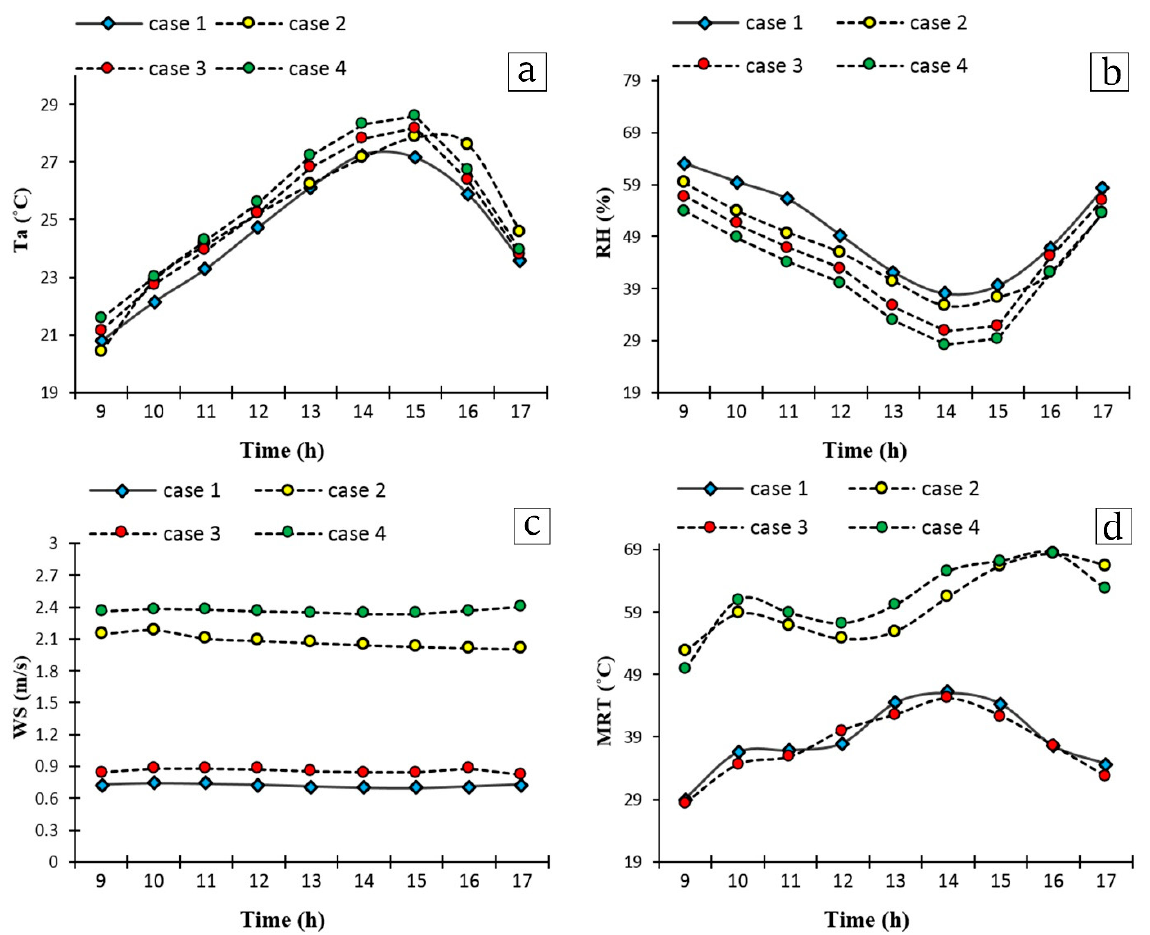
Figure 7. Average air temperature values at the site (1.5 m agl) in all scenarios: ( a ) during on the hottest day of the year ;( b ) relative humidity; ( c ) wind speed; and ( d ) mean radiant temperature.